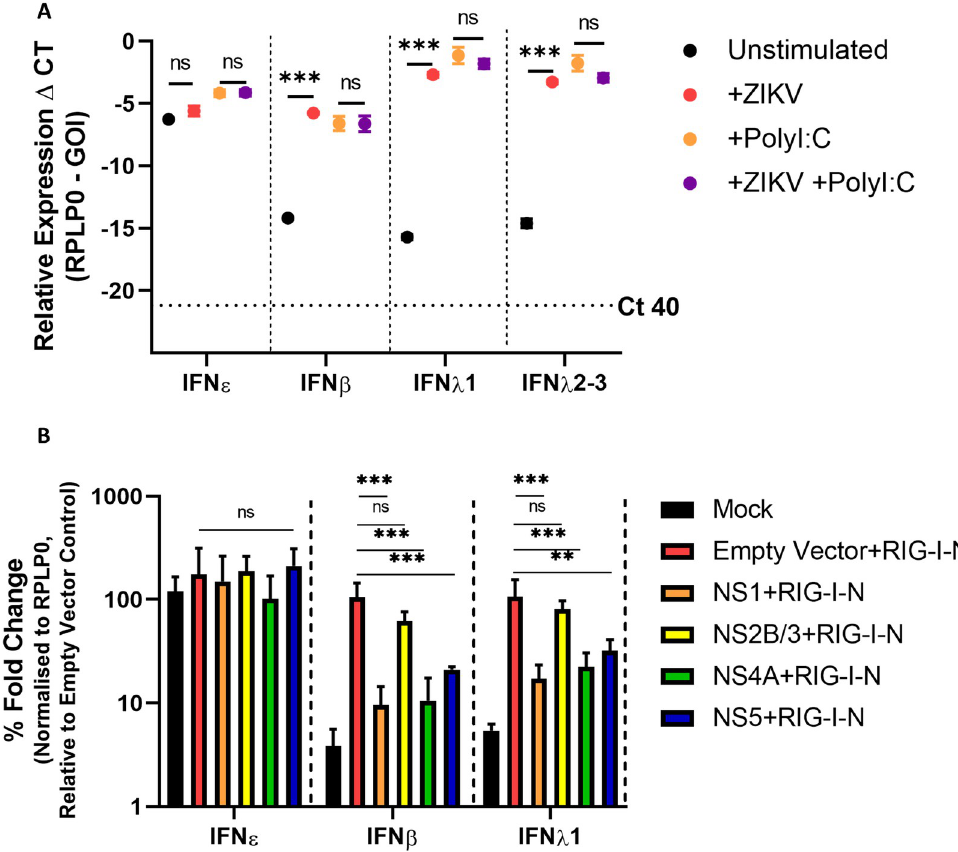
Fig 7. IFN ε RNA expression is not reduced by ZIKV infection or NS protein expression. A) HeLa cells infected for 16h MOI 1 ZIKV PRV prior to stimulation with Poly I:C 1 μ g for 8 h prior to assessing IFN gene expression by qRT-PCR. B) HeLa cells were co-transfected with expression plasmids encoding ZIKV NS1/2B/3/4A/5 or empty vector (pCDNA6.2) and the RIG-I-N plasmid or were mock transfected (Lipofectamine only), 24 h later RNA was harvested prior to assessing induction of type-I and type-III IFNs by qRT-PCR. Statistical analyses are performed by two-way ANOVA (A) or one- way ANOVA compared to the empty vector control (B), (n.s non-significant, � P < 0.05, �� P < 0.01). Data are presented as means +/-